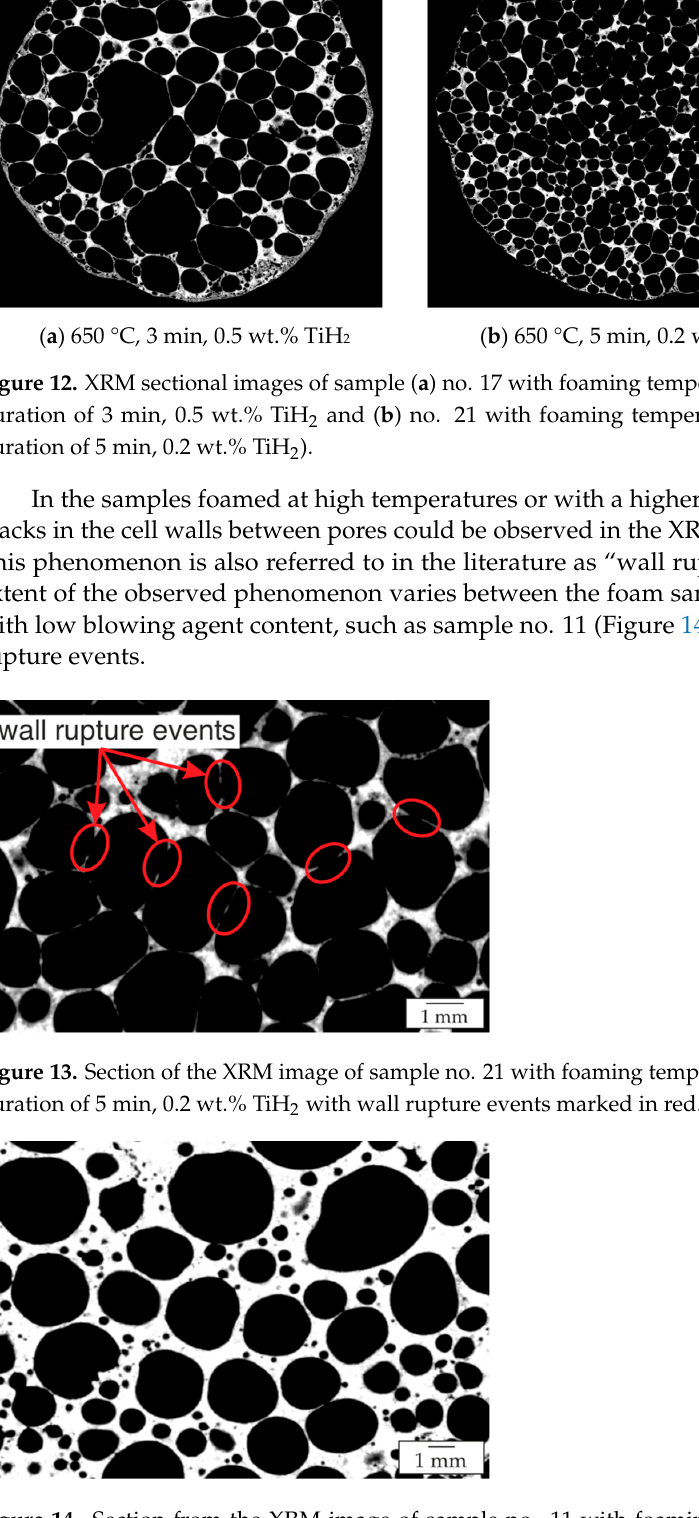
Figure 14. Section from the XRM image of sample no. 11 with foaming temperature of 600 °C, foaming duration of 7.5 min, 0.2 wt.% TiH 2 showing intact cell walls. foaming duration of 7.5 min, 0.2 wt.% TiH 2 showing intact cell